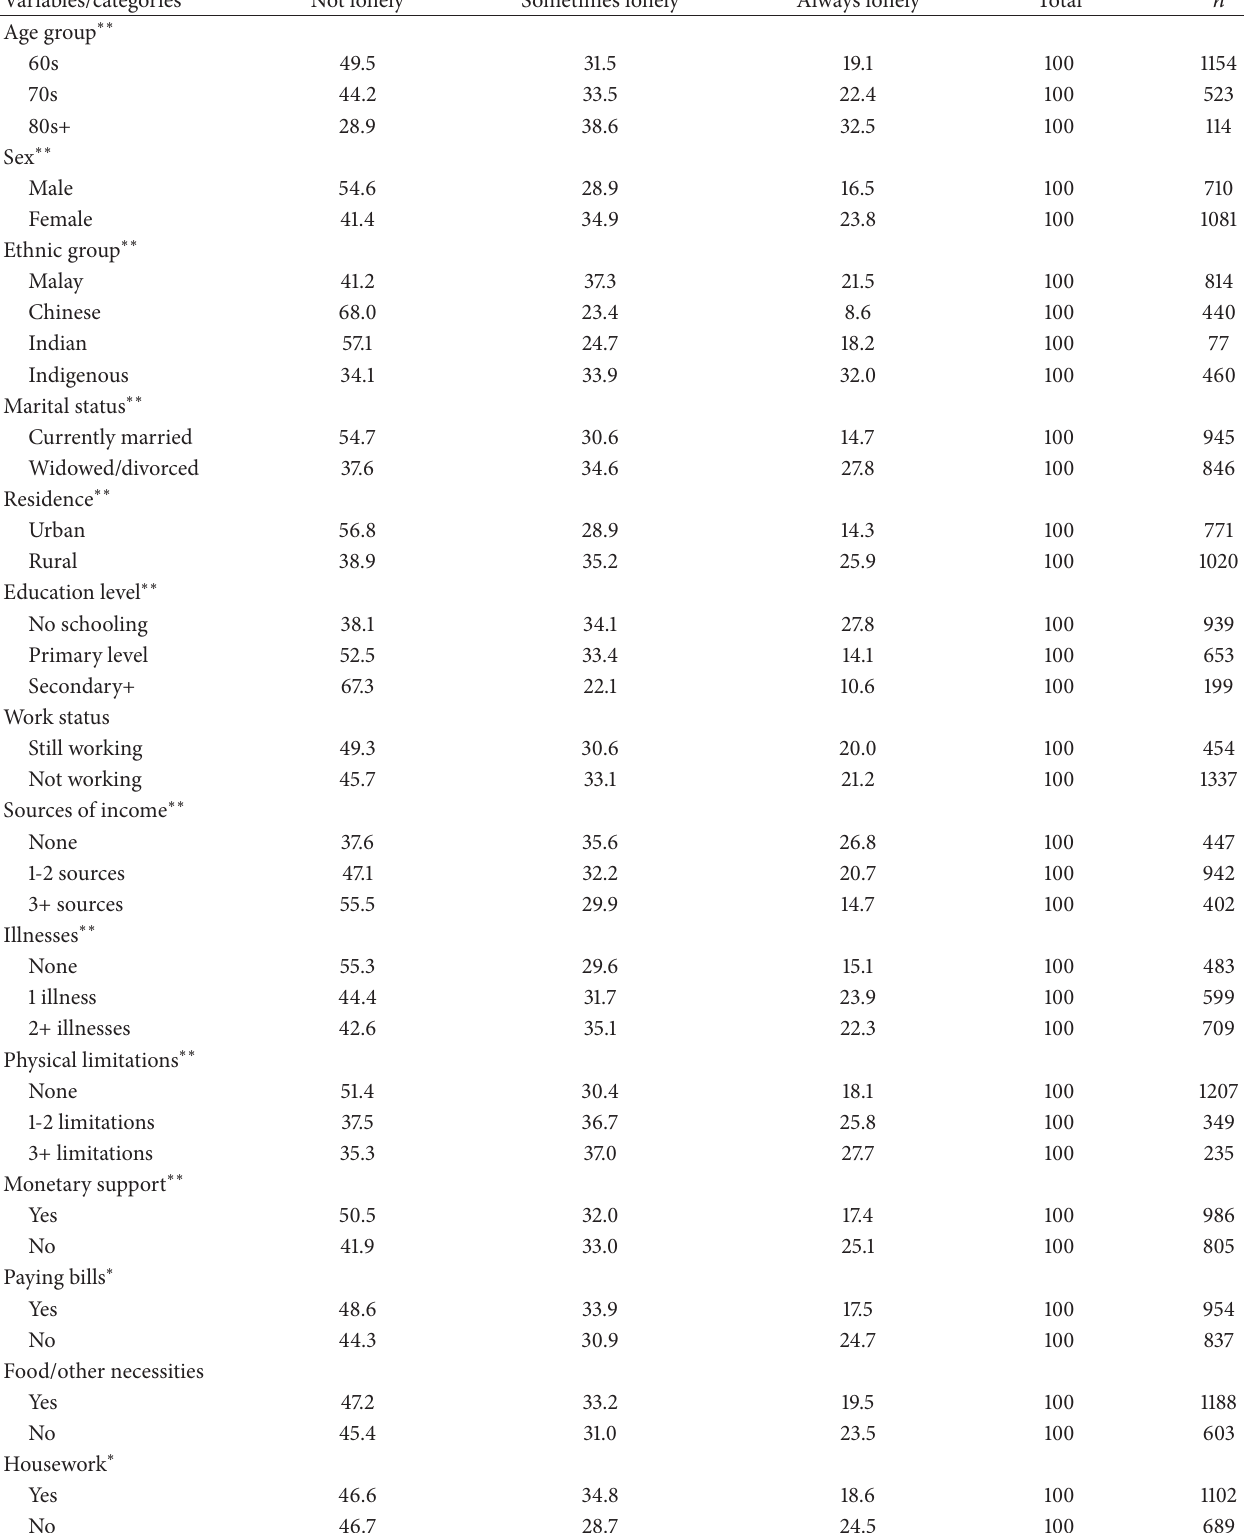
Table 3: Percentage distribution of respondents by levels of loneliness, according to selected sociodemographic and socioeconomic characteristics, health and physical condition, and various forms of family support and community engagement ( 𝑛 = 1791